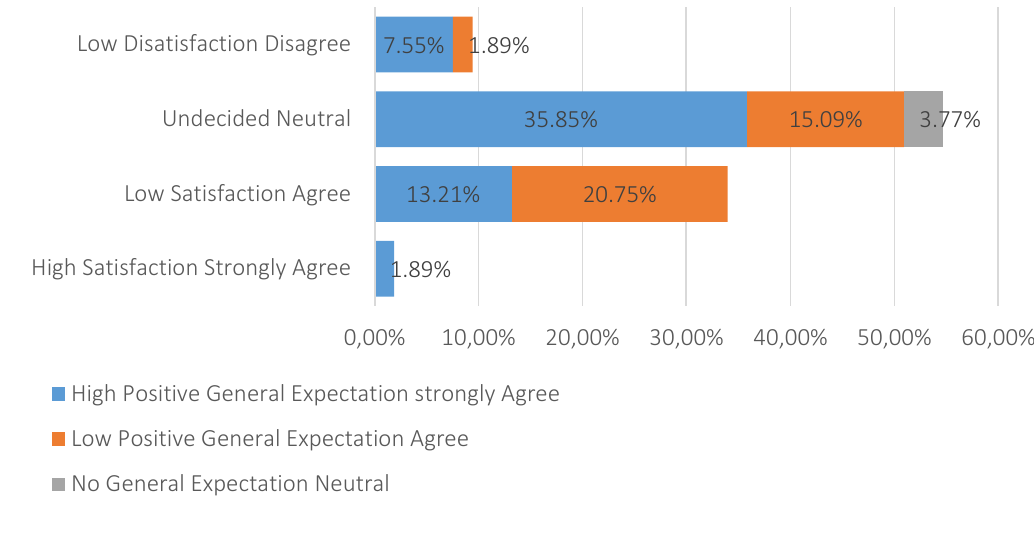
Figure 3. General expectations and user